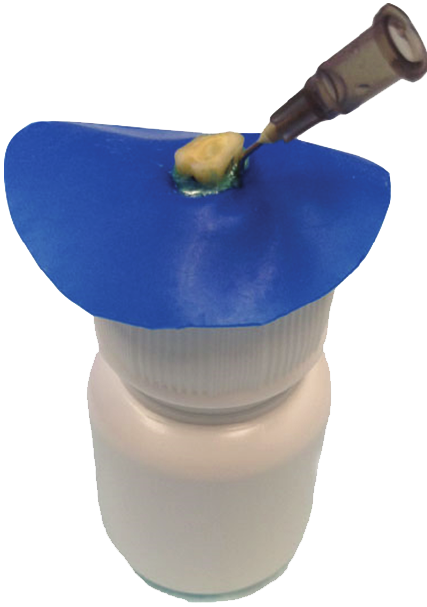
Figure 1: Modified apparatus used to evaluate the apical extrusion of